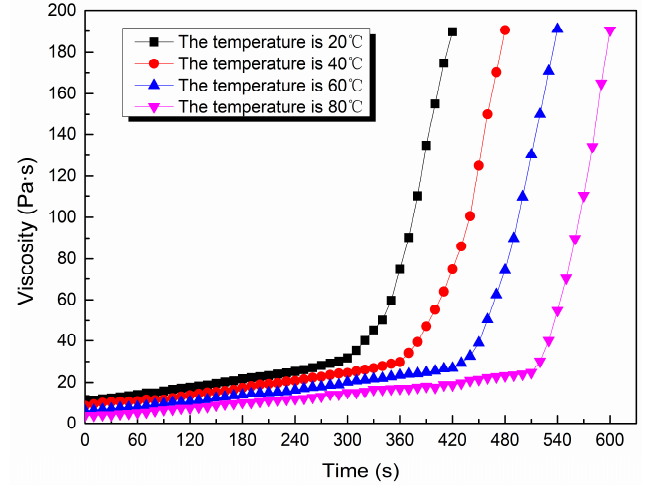
Figure 8. The time-varying viscosity curve of the HGTGS at different temperatures.